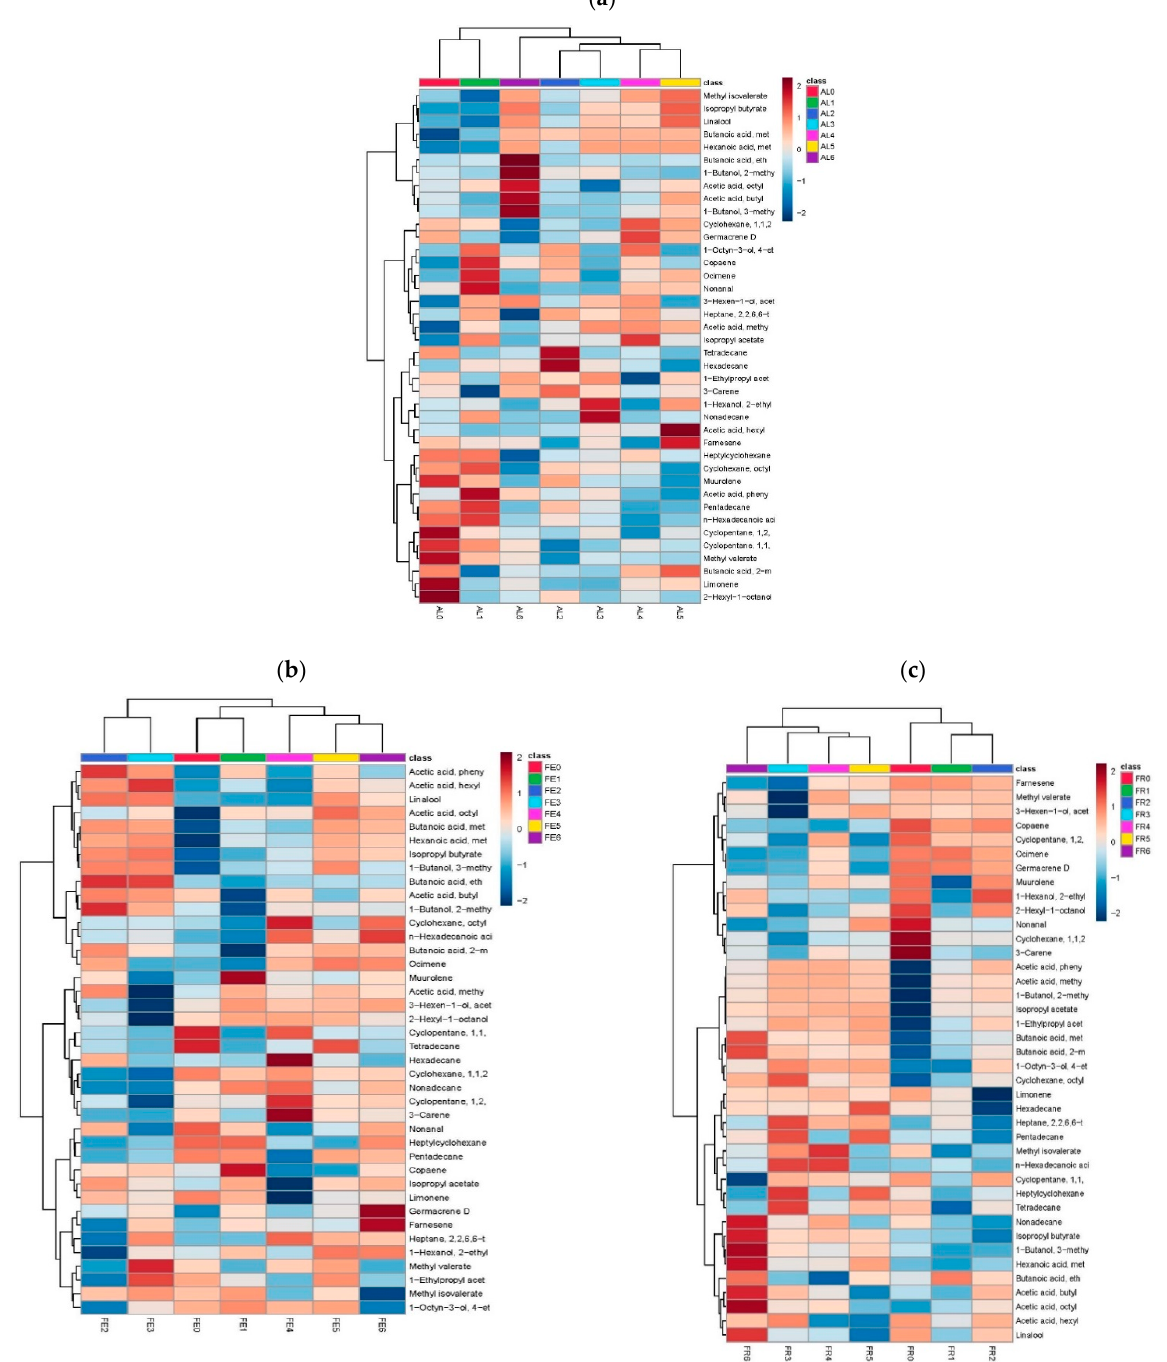
Figure 1. The heat map and hierarchical clustering analysis of metabolic profiles from maturation stages of the strawberry fruits. Rows: Volatile organic compounds (VOCs) identified; columns: maturation stages. The correlation matrix is represented by a color gradient in which dark blue indicates a negative correlation and dark red indicates positive correlation (Pearson Correlation Coefficient). This color matrix results in the grouping tree shown at the top of the figure, which groups the phenological maturation stages that do not differ significantly from each other on the same branch, and separates stages that do differ significantly on different branches; ( a ) heat map for var. Albion; ( b ) heat map for var. Festival; ( c ) heat map for var. Frontera.